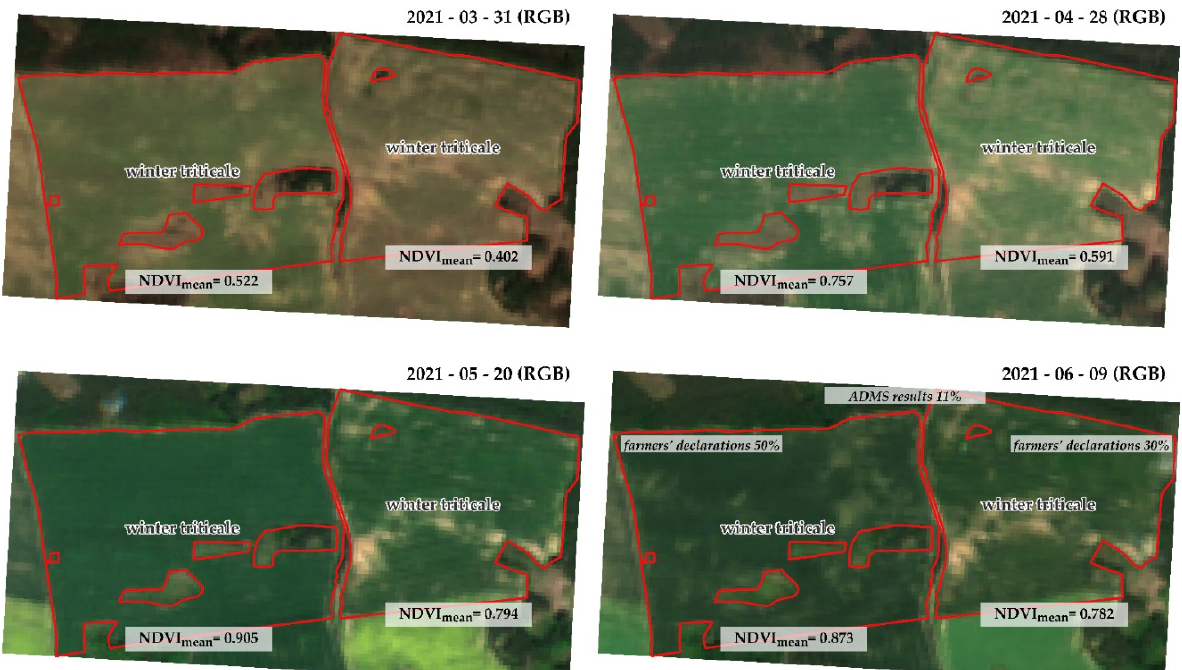
Figure 8. Comparison of adjacent fields with triticale cultivation using different farming techniques: field on the left—fertilization with manure, rapeseed-cereal rotation; field on the right—mineral fertilization, cereal-cereal rotation. In both cases, the farmer assumed a yield of 6 t/ha. Source: own study (IUNG-PIB).